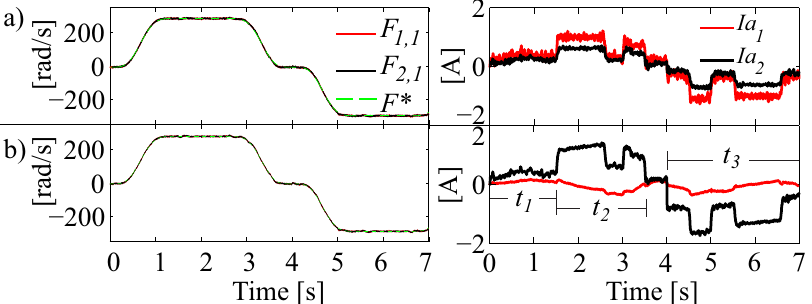
Figure 10. Angular velocity response and its corresponding armature current responses: ( a ) with digital torque coupling and ( b ) without digital torque coupling.